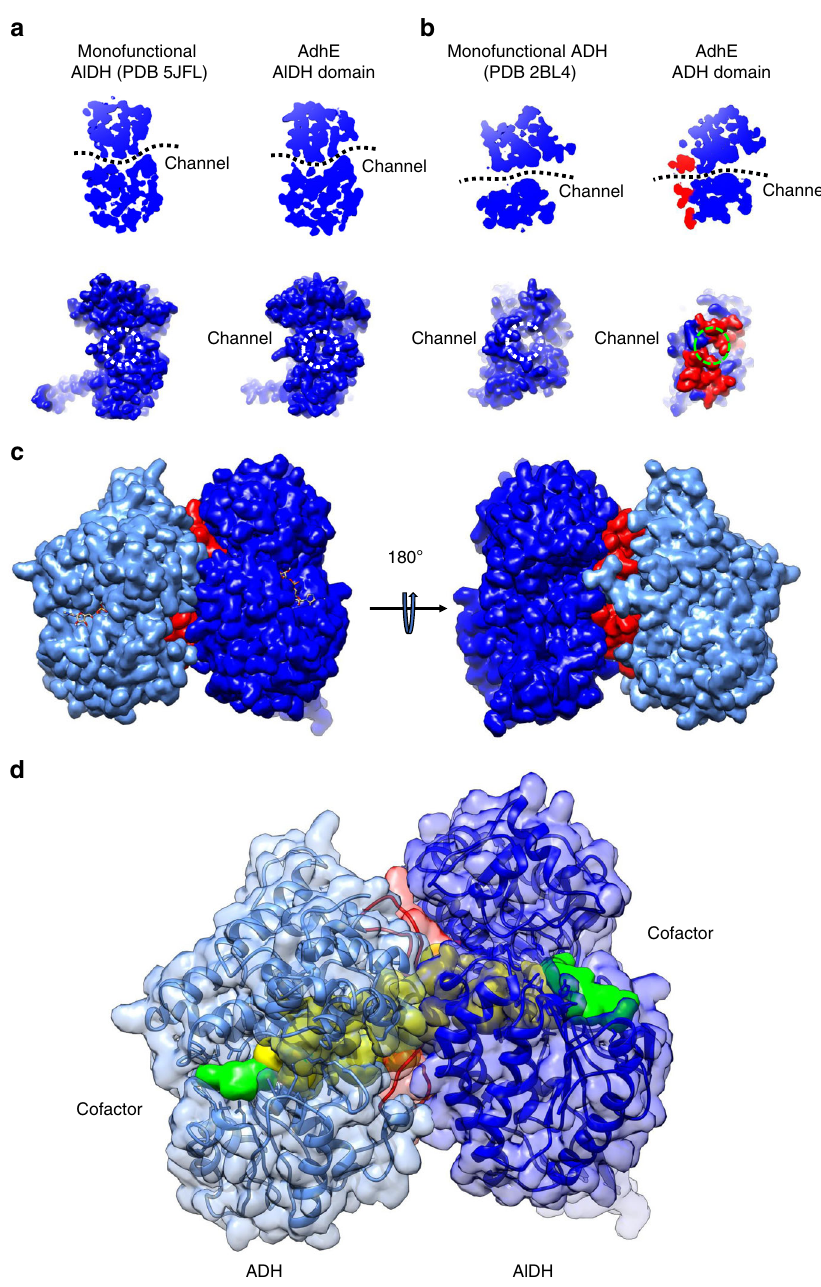
Fig. 4 A continuous channel between the ADH and AlDH active sites. a A conserved channel crosses the monofunctional propionaldehyde dehydrogenase from R. palustris (left panels). This channel is conserved in the AlDH domain in AdhE (right panel). Top, cut-out slice through the AlDH domain of the bottom, surface representation of the AlDH domain showing the substrate entrance/exit channel (opposite of the NAD-binding channel). b A conserved channel crosses the monofunctional lactaldehyde : 1,2-propanediol oxidoreductase from E. coli (left panels). This channel is conserved in the ADH domain in AdhE (right panel). Top, cut-out slice through the ADH domain of the bottom, surface representation of the ADH domain showing the substrate entrance/exit channel (opposite of the NAD-binding channel). c Surface representation of ADH α (in light blue) and AlDH β (in blue). The loops 2 and 3 from ADH α are colored in red. d A channel connects directly the active sites of ADH α (in light blue) and AlDH β (in blue). The domains are represented as transparent surfaces and ribbons with the same color code than above. A surface representation of channel is colored in yellow. Surface representations of NAD + molecules bound to ADH and AlDH domains are colored in